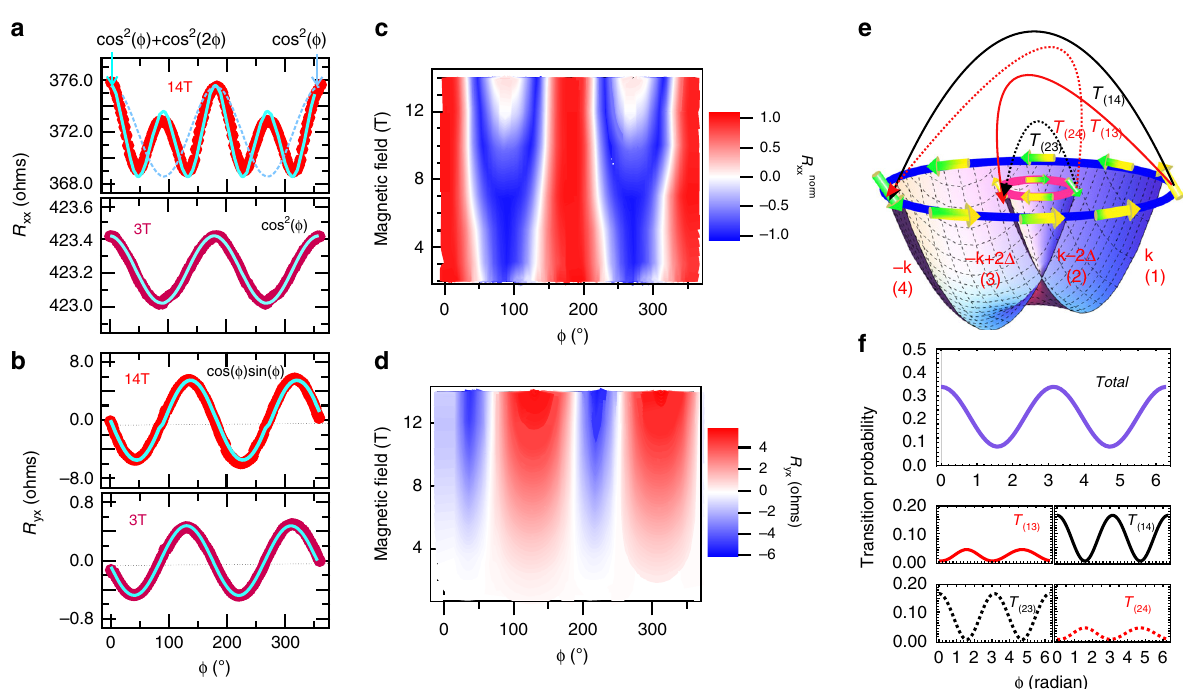
Fig. 4 PHE and AMR measurements. (Color online) a , b Angle dependent R xx and R yx measured at 1.8 K for 14 T and 3 T. Blue line is the fi tted curve. c , d Applied magnetic fi eld and angle dependent contour plots for normalized R xx and R yx . e Rashba energy-split bands showing spin-texture at a particular energy and the allowed electronic transitions. f Total probability and individual probabilities for different allowed electronic transitions between the bands.